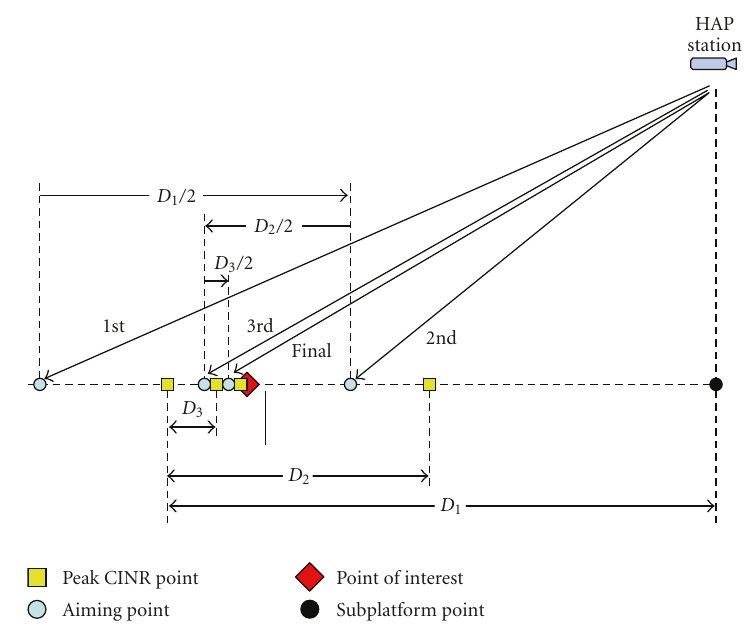
Figure 11: The half distance scheme description.